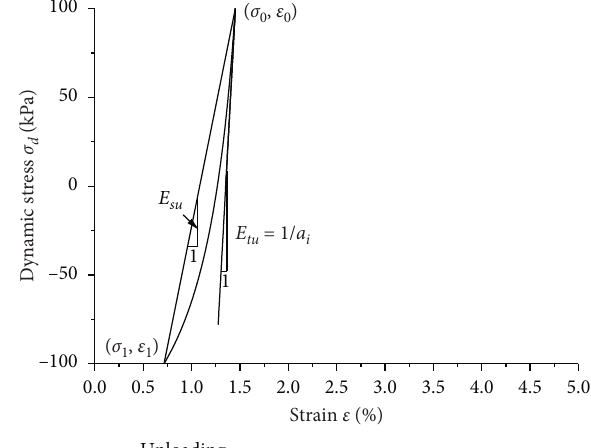
u in the unloading stage.